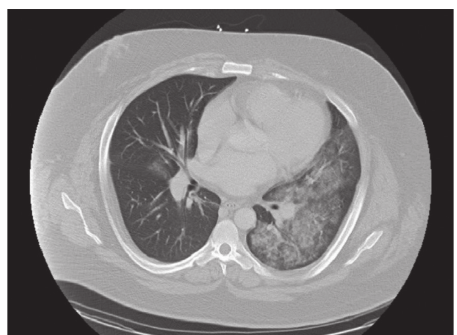
Figure 1: Computed tomographic angiogram of the chest showing bilateral infiltrates more extensive on the